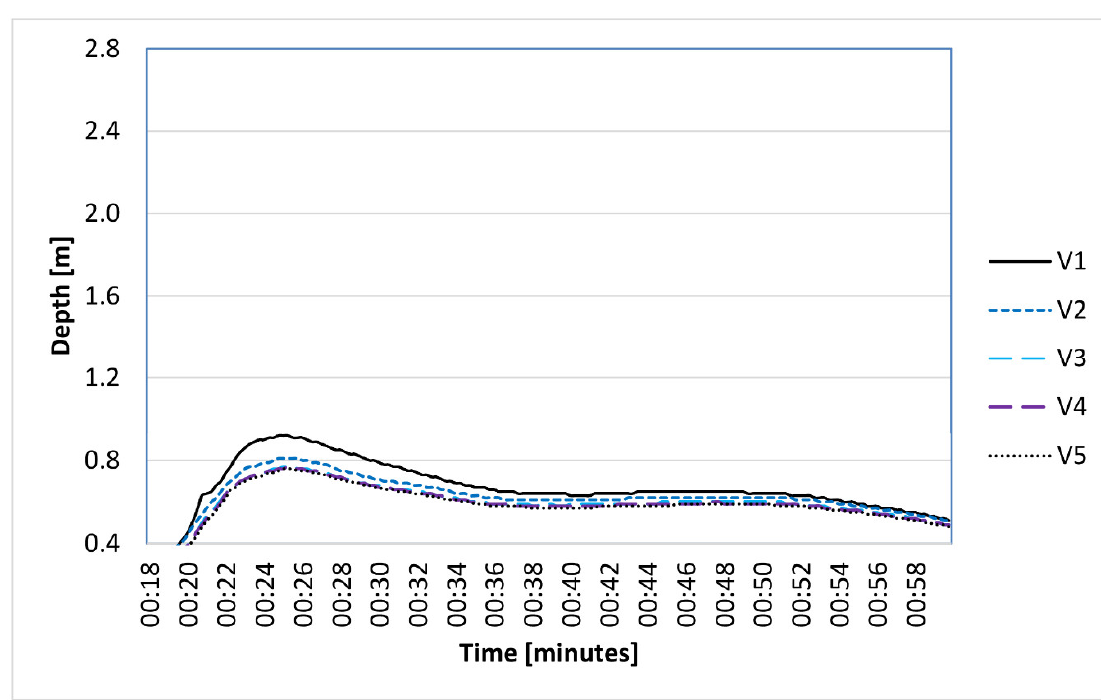
Figure 13. Depth change in Link-30 canal—F = 2 years.